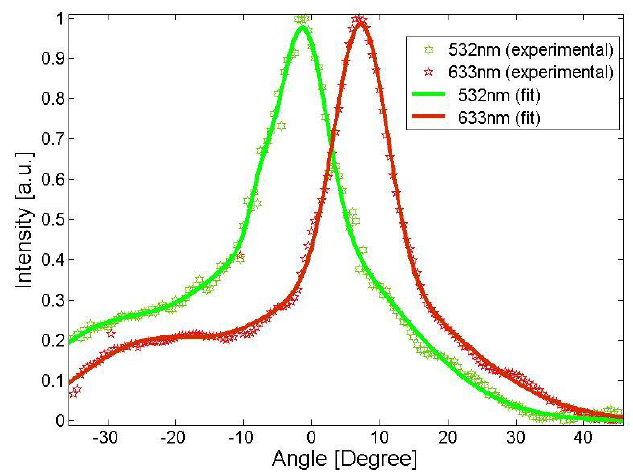
Figure 7. Angular scan for the volume holographic lens at three different wavelengths. The interpo- lating fit lines in the figure are guide for the eye.